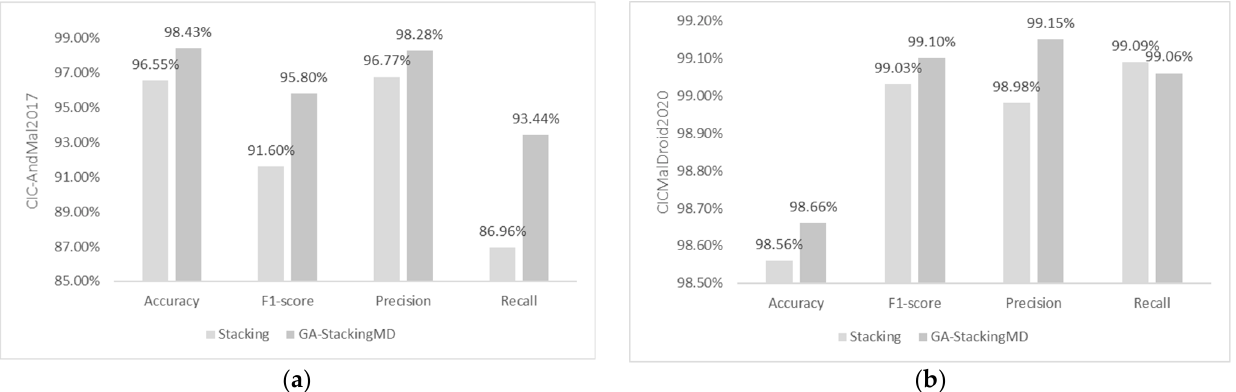
Figure 6. ( a ) CIC-AndMal2017: Comparison of GA_StackingMD and Initial Stacking Model; ( b ) CIC- MalDroid2020: Comparison of GA_StackingMD and Initial Stacking Model.